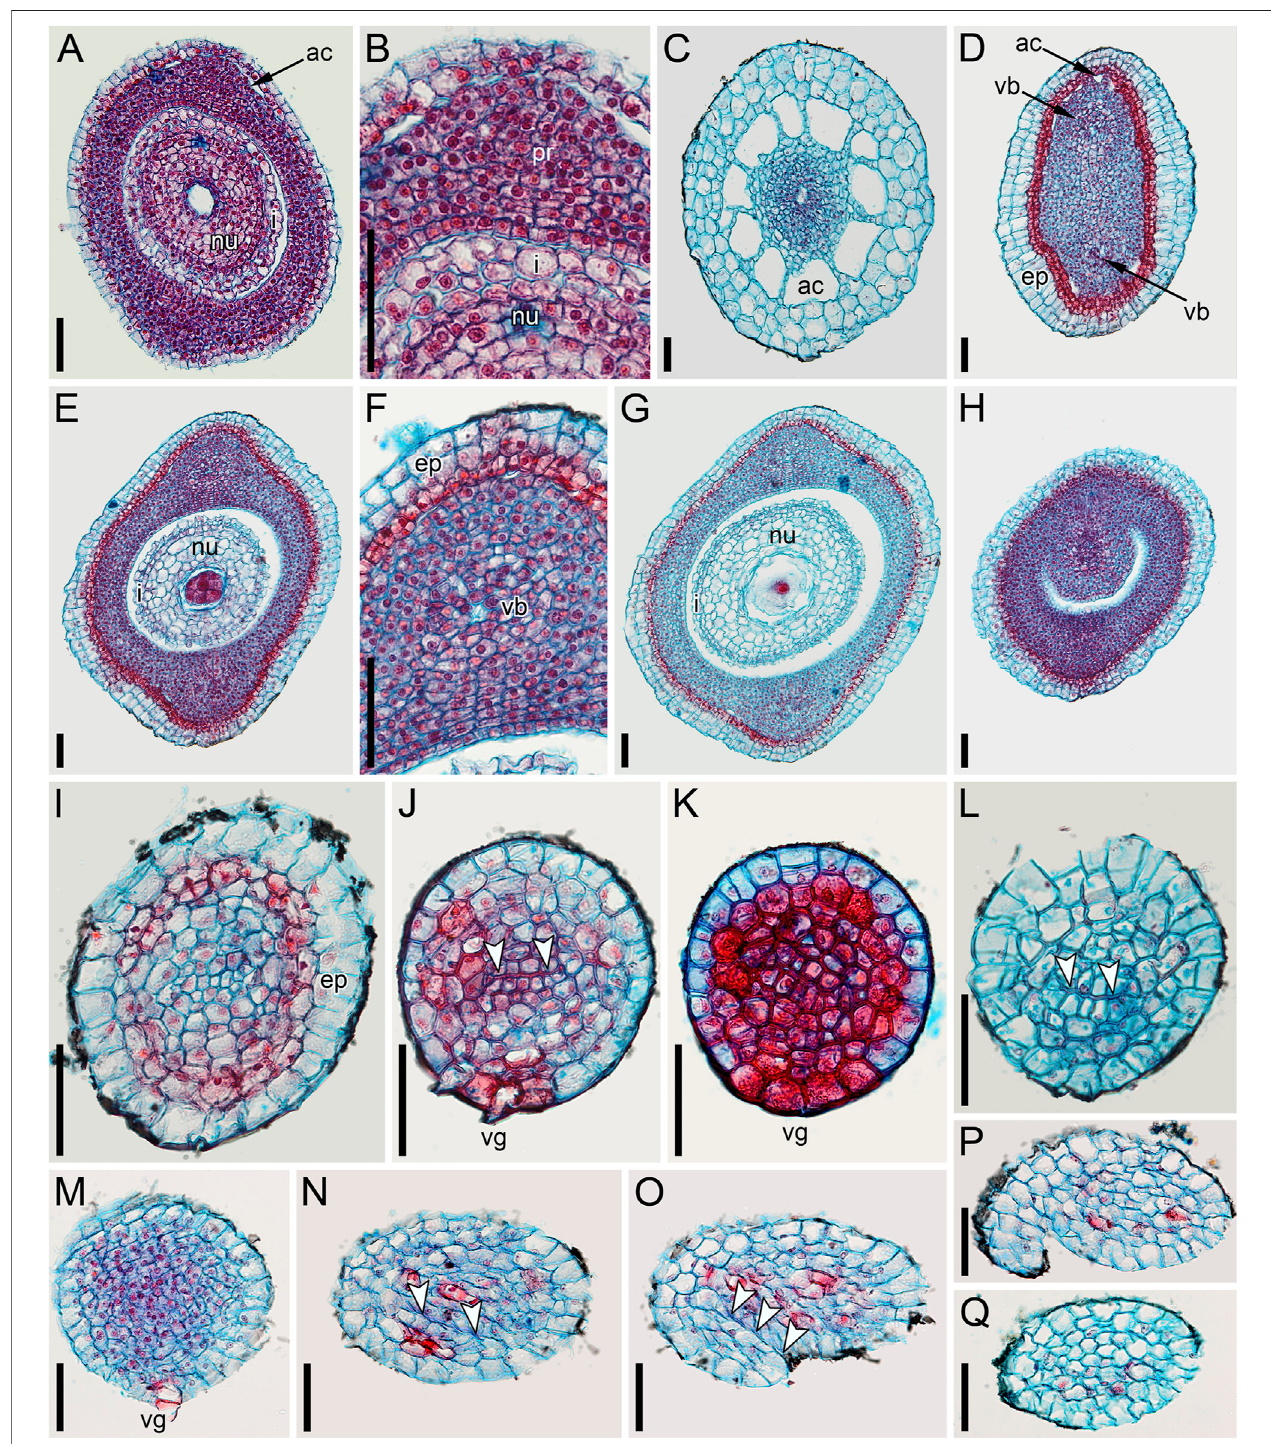
FIGURE10| Pistillate fl oweranatomyof Ceratophyllumtanaiticum (A – L) and C.submersum (M – Q) ,transversesections,LM.Adaxialsideupinallimages. (A,B) Midsection of anthetic ovary (A) and detail of its adaxial side showing poorly recognizable procambium strand (B) . (C – L) Ascending serial sections of postanthetic fl ower similar to that in Figure9E ;involucralappendagesremovedbeforesectioning. (C) Stalkofpistillatereproductiveunit. (D) Belowtheovaryloculeandabovetheinsertionofinvolucralappendages. (E – H) Ovarylocule.Notethatnotethatthe epidermis isbiseriatein (D – H) . (E) Bottomoftheovuleshowingglobularproembryo(redcellsinthecentre). (F) Detailofadaxialpart oftheovarywallfrom (E) showingvascularbundle. (G) Middlepartoftheovulewithalargeendospermcellinthecentre. (H) Levelofovuleattachment. (I – L) Abovetheovarylocule (arrowheads,stylarcanal). (J,K) Levelofvestigialgland. (M – Q) Ascendingserialsectionsofanthetic fl owerabovetheovarylocule(arrowheads,stylarcanal).The fl owerissimilarto thatin Figures11D , 12D . (M) Levelofvestigialgland(onlytwoglandcellsvisible). (N) Abovethegland. (O) Asymmetricgynoeciumori fi ce. (P) Asymmetricproximalpartofadaxial distal outgrowth of gynoecium. (Q) Symmetrical distal part of the outgrowth. Scale bars = 50 μ m in (A – Q) .